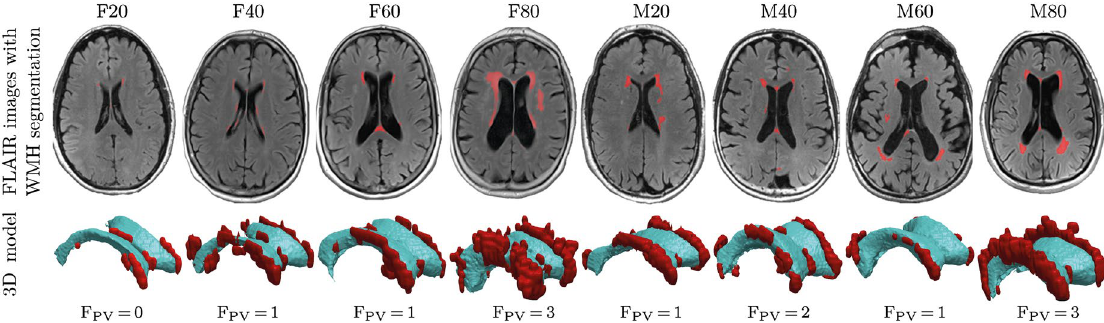
Figure 2. Representative axial slices and volumetric reconstructions of lateral ventricles and white matter hyperintensities from eight subjects. We sorted 464 subjects from the NYU ADRC’s imaging database based on their total intracranial CSF volume and picked a male and female subject from the 20th, 40th, 60th, and 80th percentile. The top row shows the FLAIR MRI sequence of all eight patients with a white matter hyperintensity mask (red); the bottom row shows volumetric reconstructions of their ventricles (blue) and white matter hyperintensities (red). We also provide the Fazekas score of the periventricular